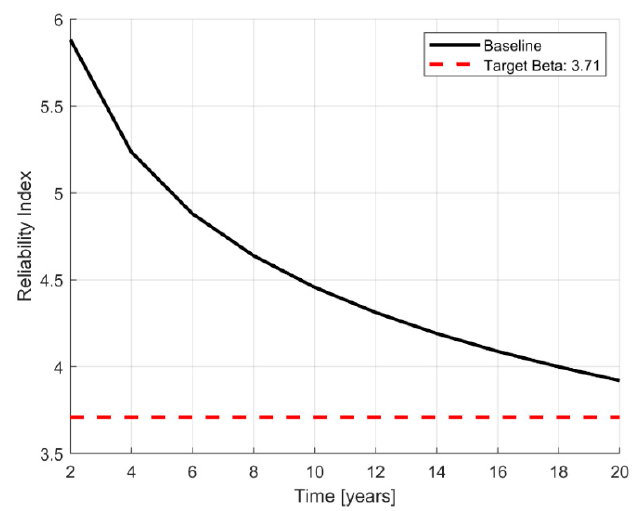
Figure 10. Fatigue reliability assessment (non-intrusive formulation).